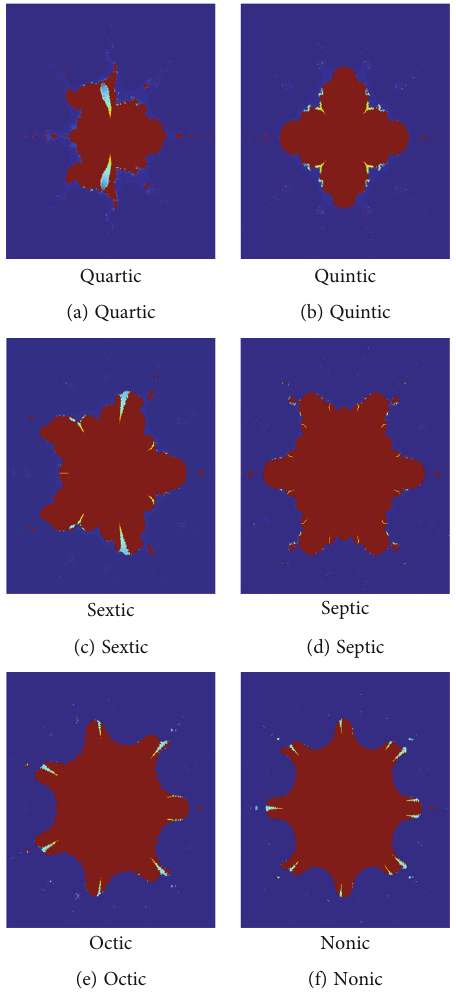
Figure 8: E ff ect of change in n on Mandelbrot set. Table 6: Parameters for generation of Mandelbrot set for di ff erent values of n .